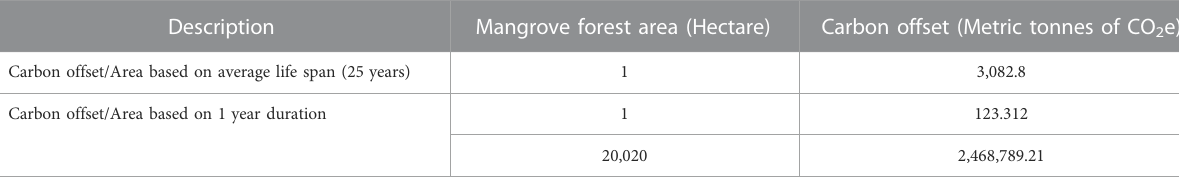
TABLE 15 Mangroves vis-a-vis carbon offset